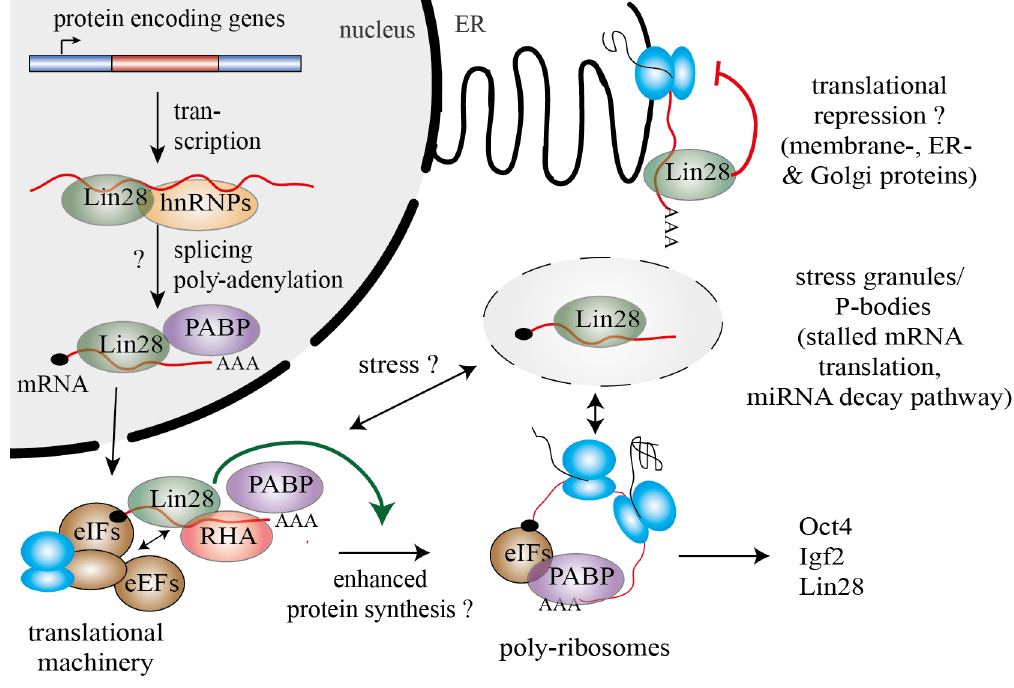
Figure 3. Lin28 binds various mRNAs and modulates their translation. Both Lin28 paralogs were shown to influence mRNA processing on several levels. In the nucleus, Lin28 could regulate splicing of bound pre-mRNAs in concert with heterogeneous nuclear ribonucleoproteins (hnRNPs). In the cytosol, Lin28 was shown to interact with an RNA helicase A (RHA) thereby modulating the translation of target mRNAs via interactions with eukaryotic translation initiation factors (eIFS), elongation factors (eEFS) and poly(A)-binding proteins (PABP). Furthermore, Lin28 was found to shuttle mRNAs to poly-ribosomes and, under stress condition, to P-bodies and stress granules, thereby providing a direct link to the miRNA decay machinery. Lin28 binding to mRNAs was typically associated with a globally enhanced protein synthesis. However, in hESCs Lin28 binding repressed translation of bound mRNAs that were destined for the